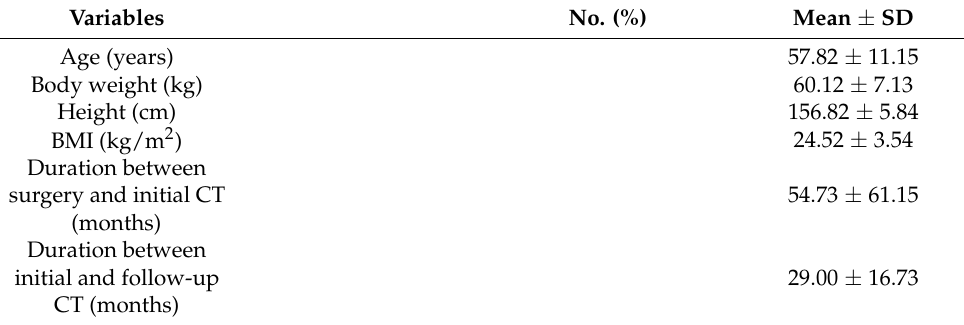
Table 1. Demographic and clinical data for patients ( n =